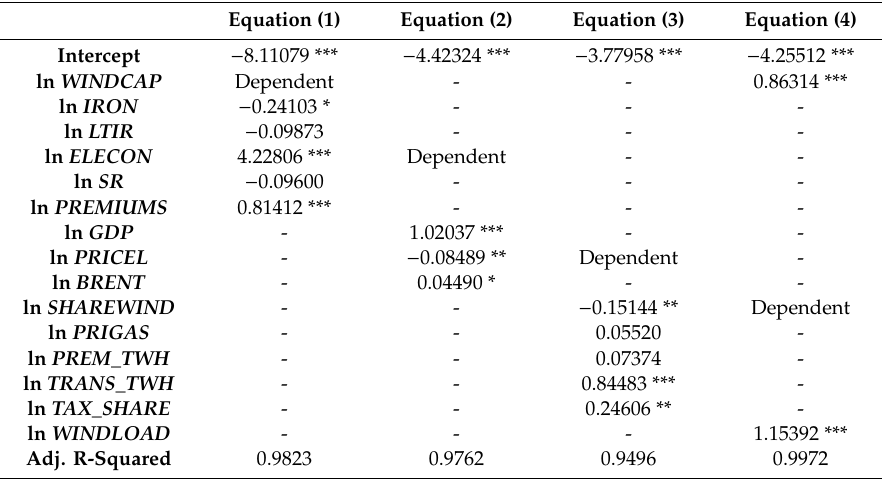
Table 4. Estimation results. Standardized coefficients.